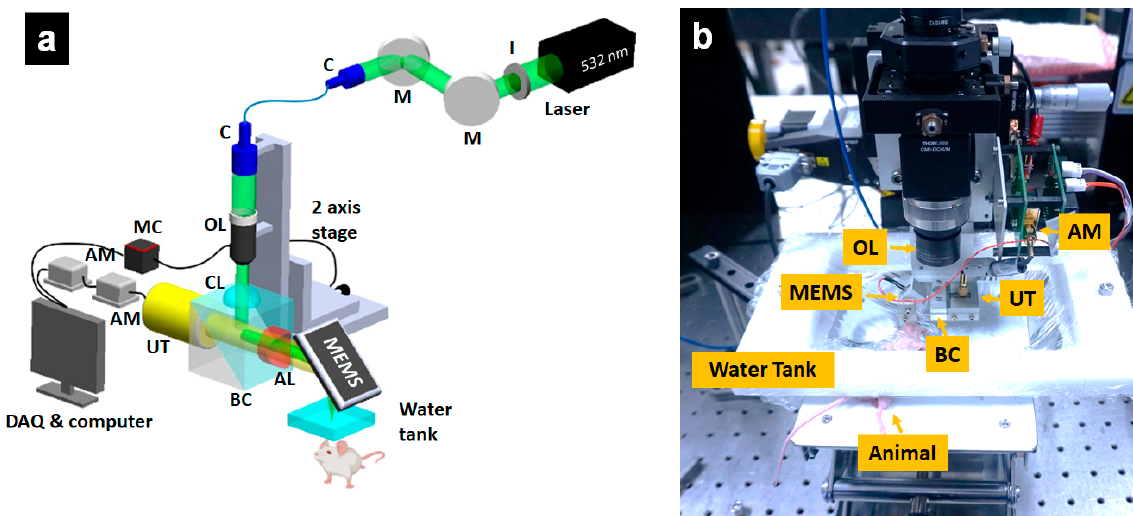
Figure 1. Optical-resolution photoacoustic microscopy (OR-PAM) system to monitor the peripheral vasculature of the mouse ear. ( a ) Schematic of OR-PAM, ( b ) Photograph of the OR-PAM probe part. I, iris; M, mirror; C, collimator; OL, objective lens, CL, correction lens, TR, transducer; BC, beam combiner; AL, acoustic lens; UT, ultrasound transducer; AM, amplifier; MC, motion controller; MEMS, MEMS